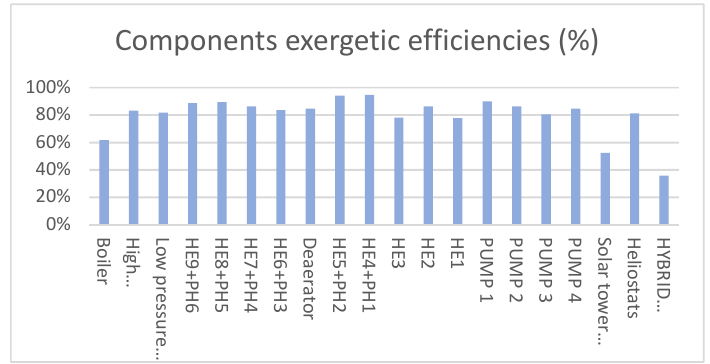
Figure 2. Exergetic efficiencies of the plant components.